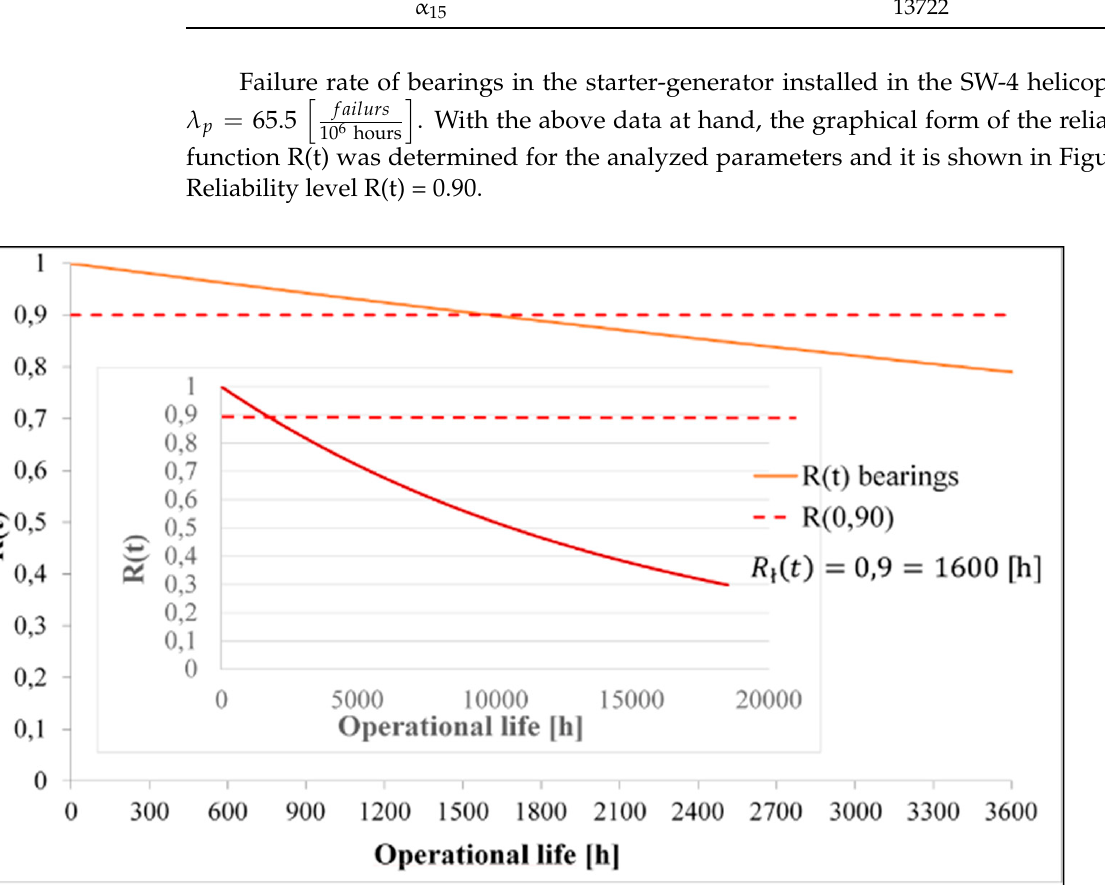
Figure 11. Reliability level R(t) for bearings of the starter-generator.